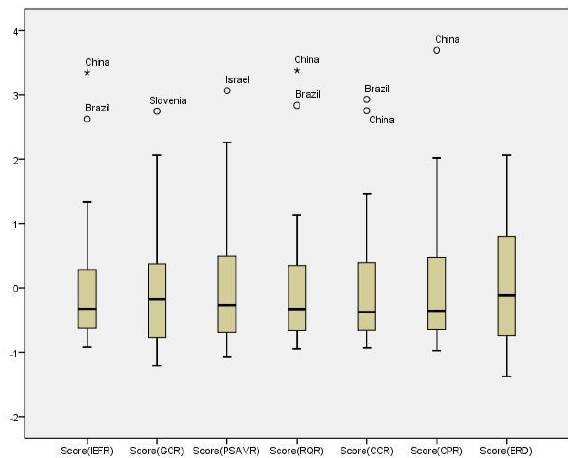
Figure 4. Bloxpot of the Macroeconomic Variables of the 30 Most Innovative Countries and Brazil for 2014.